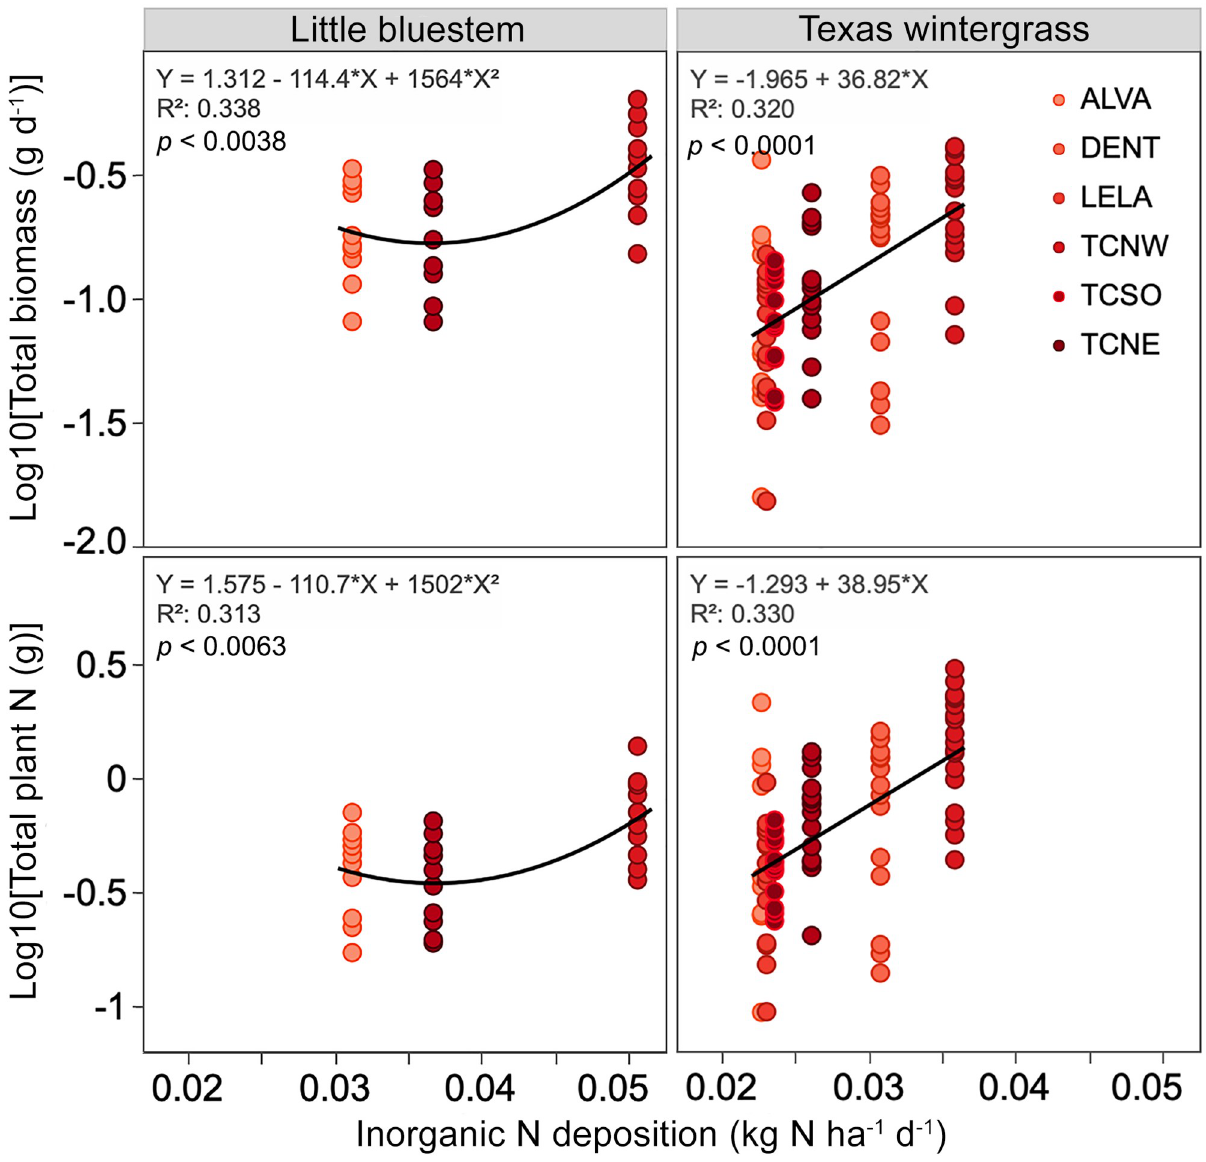
Fig 4. Prairie grass responses to nitrogen deposition. Increase in total plant biomass (g d -1 ) and total plant N (g) with inorganic nitrogen deposition (kg ha -1 d -1 ) from planting date to harvest date for little bluestem and Texas wintergrass plants at six phytometer sites in the Dallas-Fort Worth metropolitan